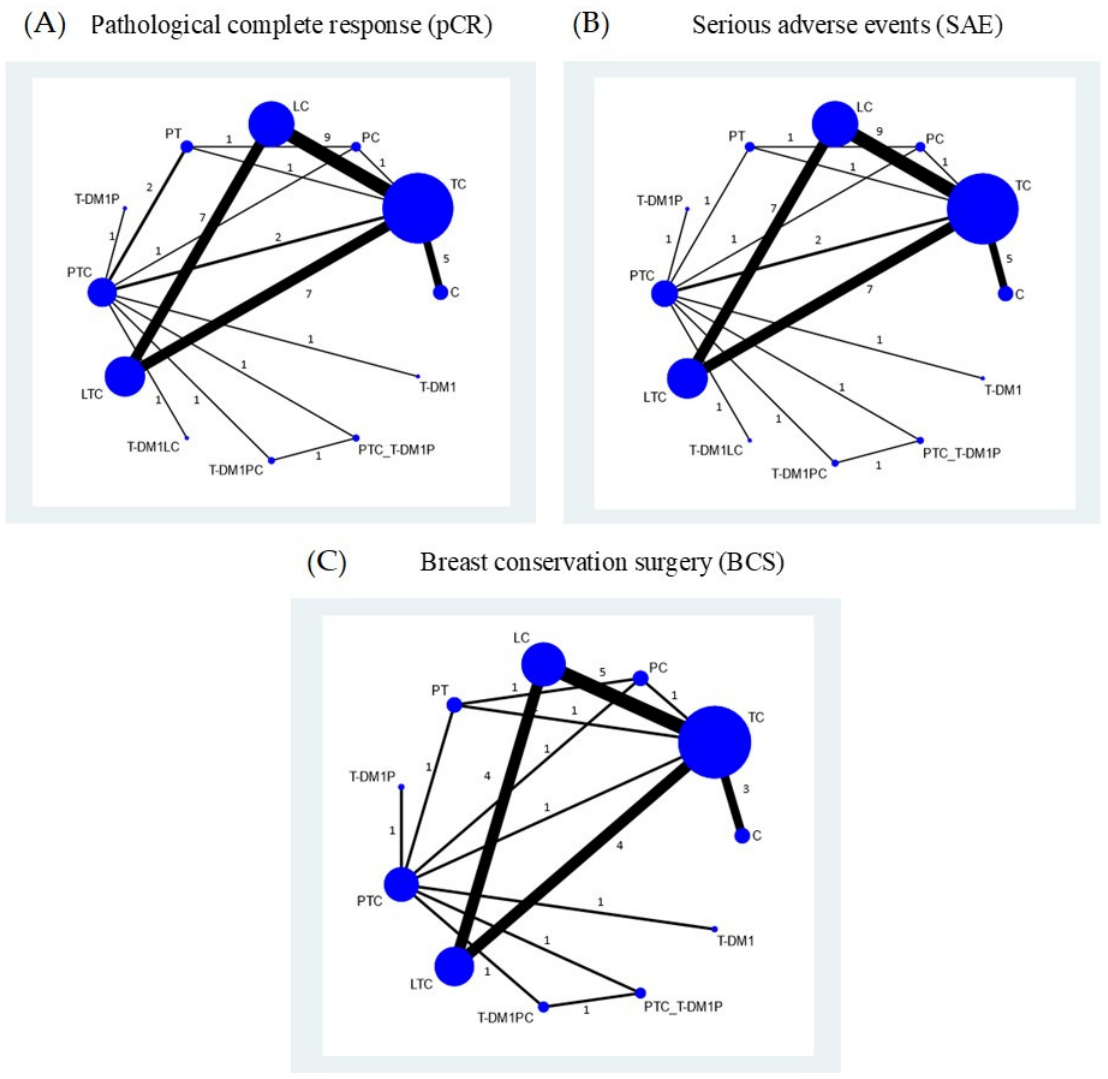
Figure 2. Network maps for ( A ) pathological complete response (pCR), ( B ) serious adverse events (SAE), and ( C ) breast conservation surgery (BCS) . Nodes and lines represent interventions and direct treatment comparisons with weighted size according to the number of studies for each direct comparison. The numbers on the lines indicate the number of studies for each treatment comparison. C = chemotherapy; TC = Trastuzumab + chemotherapy; PC = Pertuzumab + chemotherapy; LC = Lapatinib + chemotherapy; PTC = Pertuzumab + trastuzumab + chemotherapy; LTC = Lapatinib + trastuzumab +chemotherapy; PT = Pertuzumab + trastuzumab; T-DM1P = trastuzumab emtansine+ pertuzumab; T-DM1LC = trastuzumab emtansine + lapatinib + chemotherapy; T-DM1PC = trastuzumab emtansine + pertuzumab + chemotherapy; PTC_T-DM1P T-DM1 = Trastuzumab emtansine.